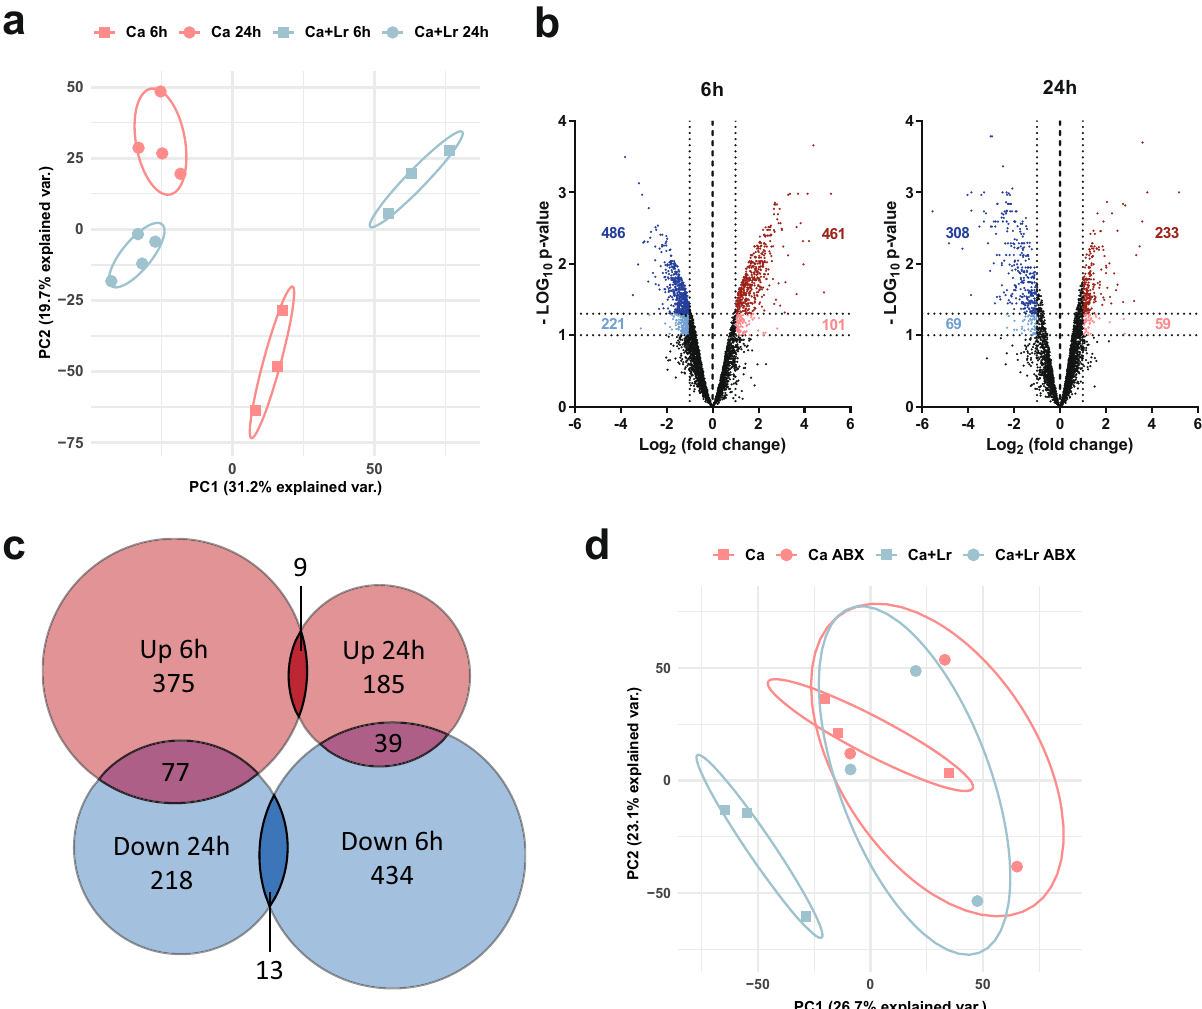
Fig. 4 C. albicans undergoes transcriptional changes during infection of L. rhamnosus -colonized IECs. a Principal component analysis of C. albicans gene expression at 6 and 24 h during in vitro infection of IECs in the presence and absence of L. rhamnosus colonization. b Volcano plots showing differentially regulated C. albicans genes at 6 and 24 hpi as a result of L. rhamnosus colonization prior to infection based on the criteria of a Log 2 fold change of >1 or < − 1 and a Bonferroni-corrected two-tailed moderated t-test p -value of <0.05 (dark blue and dark red) and <0.1 (light blue and light red). Source data are provided as a Source Data fi le. c Venn diagram analysis of the overlap in differentially expressed genes at 6 and 24 hpi. Data summarized from n = 3 and n = 4 independent experiments at 6 and 24 hpi, respectively. d PCA of C. albicans gene expression at 24 hpi during in vitro infection of IECs in the presence and absence of L. rhamnosus colonization and in the presence and absence of